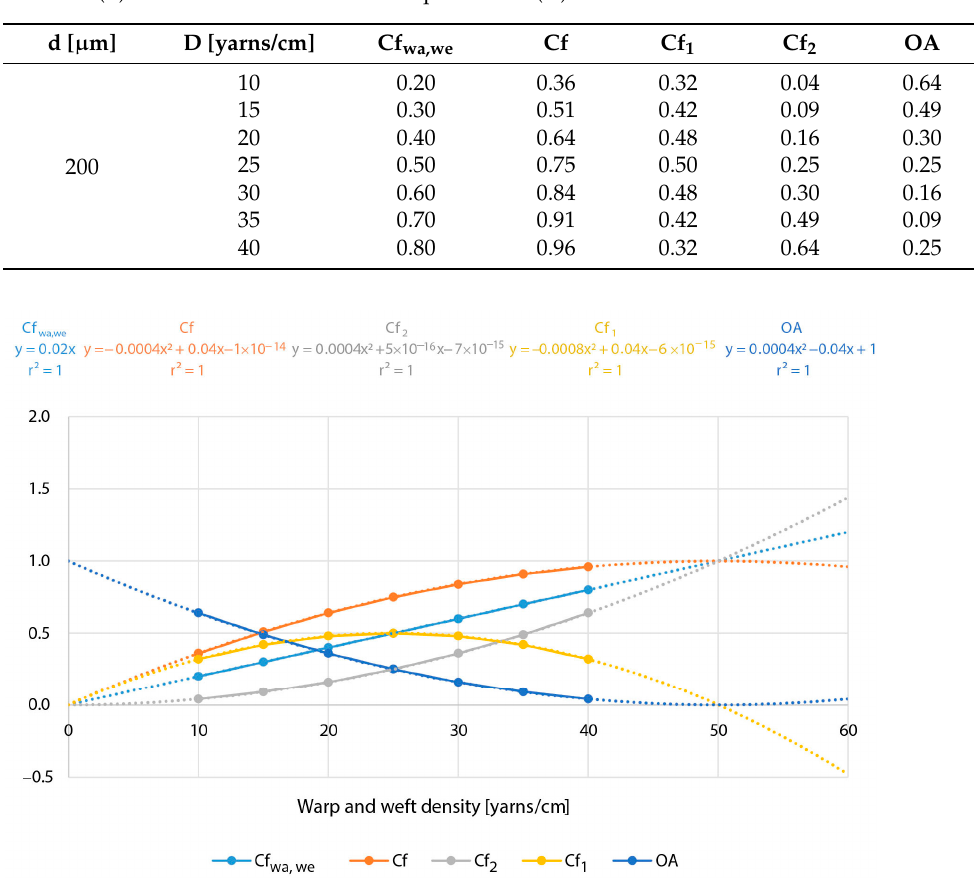
Figure 2. Cf wa,we , Cf, Cf 1 , Cf 2 and OA, depending on D with a linear line of Cf wa,we and other curves (second-order polynomial functions) and the corresponding coefficient of determination.